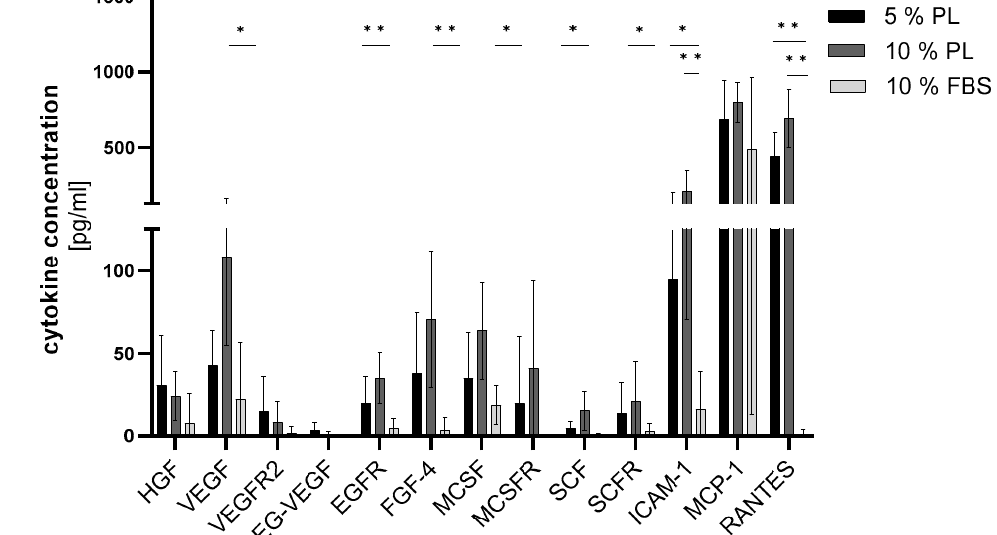
Figure 4. Effect of PL and FBS substitution in ADSC culture on cytokine concentration. Cytokine concentration ( y -axis) of different proteins ( x -axis) cohesive to proliferation and differentiation in wound healing shown as bar graph ( n = 5, triplicates, * p ≤ 0.05, ** p ≤ 0.01 in comparison to FBS).